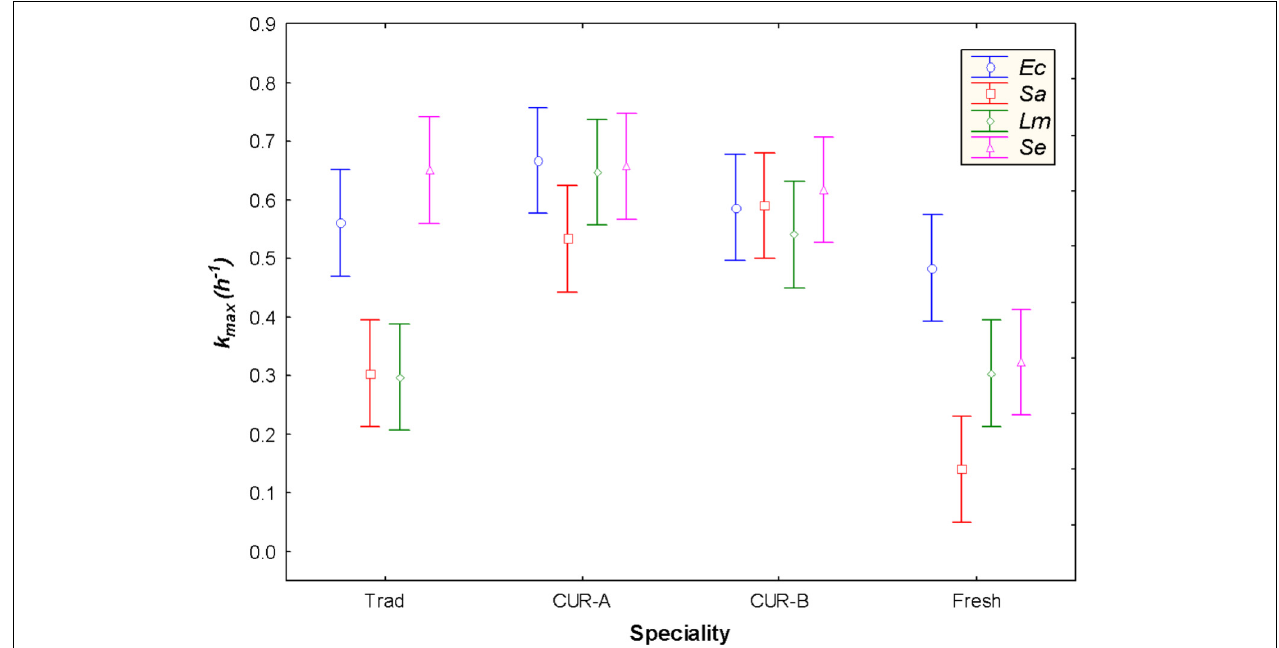
FIGURE 2 | Graphical representation of the factorial ANOVA analysis carried out for the inhibition parameters k max (maximum death rate) obtained with the log-linear regression model to the survival data of the foodborne pathogens in the different presentations ( 4Dr, time for 4 log 10 reduction, followed a similar but opposed trend). Sa, Ec, Lm and Se stand for the S. aureus, E. coli, L. monocytogenes, and S. enterica cocktails, respectively. Trad, traditional Aloreña de Málaga presentation; Fresh, fresh green presentation; CUR-A and CUR-B refer to the two industries which elaborated the cured presentations. Vertical bars denote 0.95 confidence